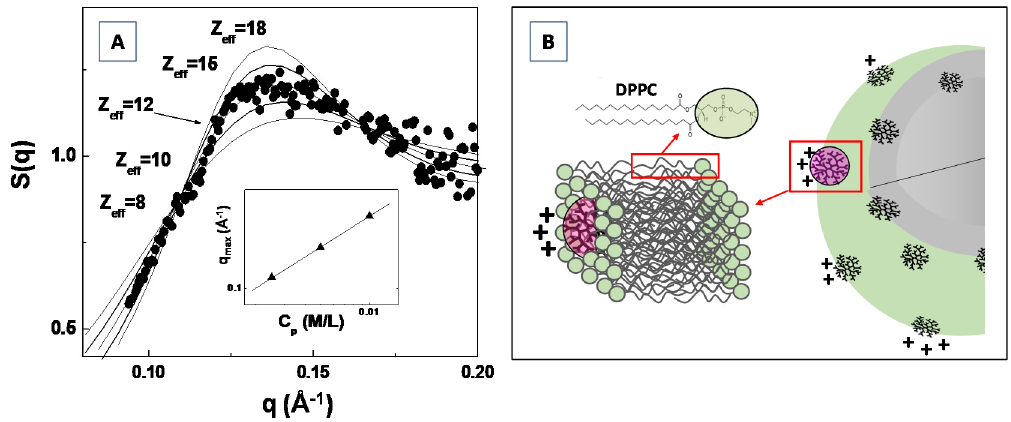
Figure 11. Analysis of the SAXS structure factor S ( q ), by means of the theoretical hypernetted chain (HNC) closure relation, for the amine terminated generation G4.0 PAMAM dendrimers in water solution ( A ). Charge attenuation effect of G4.0 PAMAM dendrimers, during their inclusion in model DPPC lipid bilayer system ( B ).